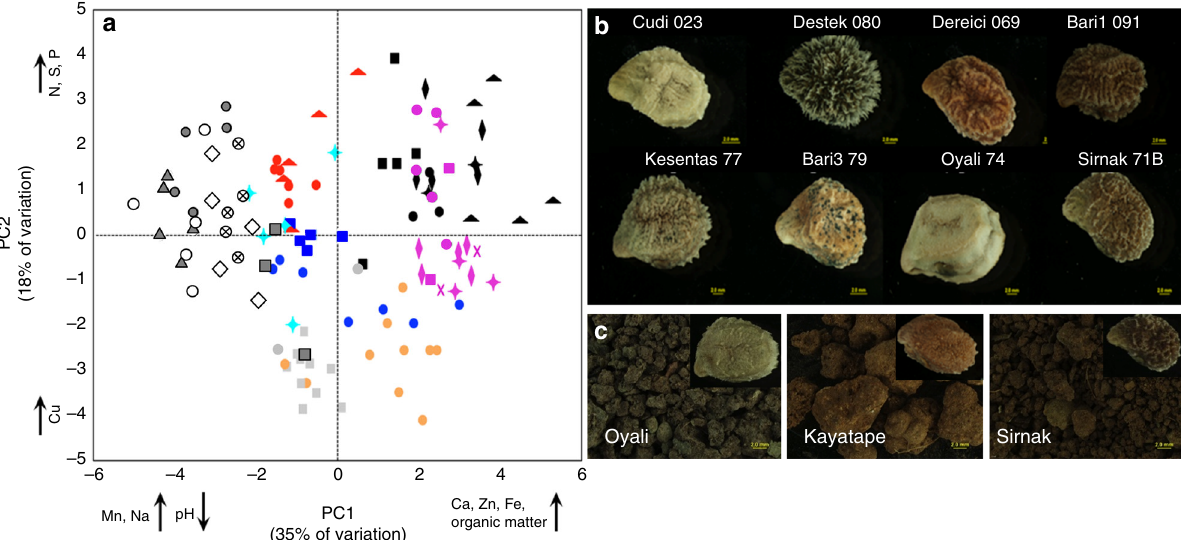
Fig. 2 Variation in soil chemistry and cryptic matching of soils by wild Cicer seed color. a Principal component analysis of variation in 18 soil factors, with fi ve samples from each collection site. Loading on the fi rst two axes explains 35 and 18% of the variation. Factors with high loading (above 1.0) are indicated on the axes. Shapes and colors correspond to distinct fi eld sites. C. echinospermum sites: Cermik — open circle with “ X ” ; Güna ş an — gray triangle; Güvenli — open diamond; Karabahce — open circle; S2Drd — gray circle; Ortanca — gray square. Common colors among C. reticulatum fi eld sites re fl ect adjacency of locations: Baristepe1 — pink circle; Baristepe1 agricultural soil — pink “ X ” ; Baristepe2 — pink star; Baristepe3 — pink diamond; Baristepe3 agricultural soil — pink square; Be ş evler — black triangle; Dereiçi — black diamond; Sarikaya — black square; Savur — black circle; Egil — red triangle; Kalkan — red circle; Kayatape — black star; Kesenta ş — light blue star; Oyali — orange circle; Cudi A/B — royal blue circle; Ş ı rnak — royal blue square. C. bijugum : Dargrecit — gray circle; Kilavuz — gray square. b Variation in seed color and texture. Seeds of eight distinct lines representing the range of color and texture variation are shown. c Color matching of seeds and dry soils. Seeds and soils from Oyal ı , Kayatape, and Ş irnak are